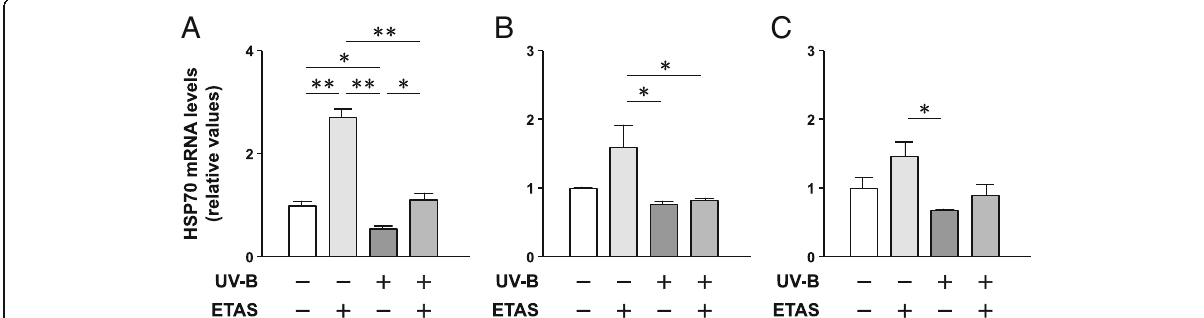
Fig. 1 Effect of EAS pretreatment on the UV-B irradiation-induced reduction in HSP70 mRNA levels in NHDFs. The cells were treated with EAS or dextrin for 24 h ( a ) and 3 h ( b ); immediately after UV-B irradiation, the cells were further cultured in supplemented medium for 3 h. c Cells were treated with EAS or dextrin for 24 h; immediately after UV-B irradiation, the cells were further cultured under EAS-free condition for 3 h. The relative ratios of HSP70 with respect to 18S are shown. Mean ± SEM ( n = 4). * p < 0.05; ** p < 0.01 (one-way ANOVA and Tukey ’ s